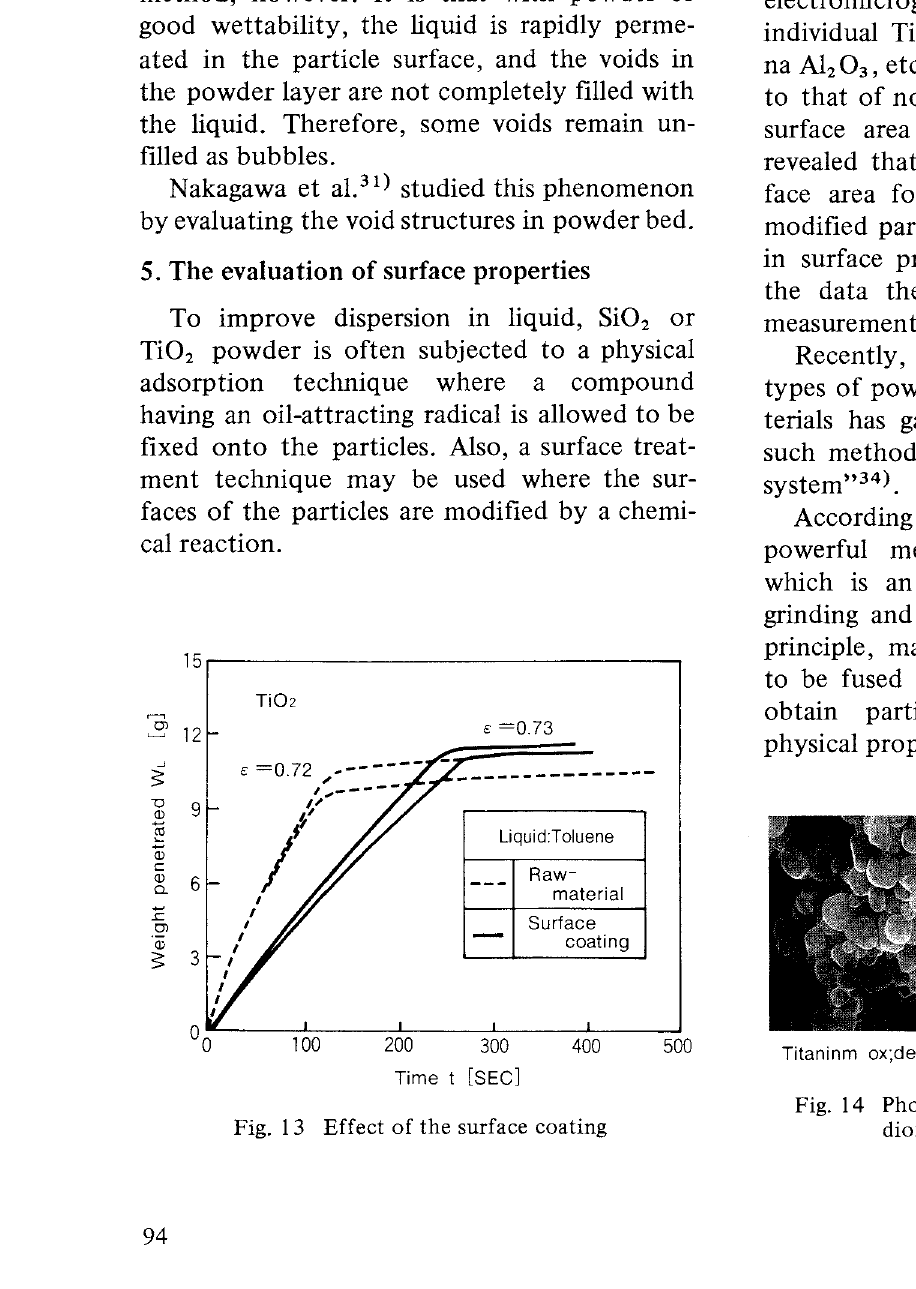
Fig. 13 Effect of the surface coating